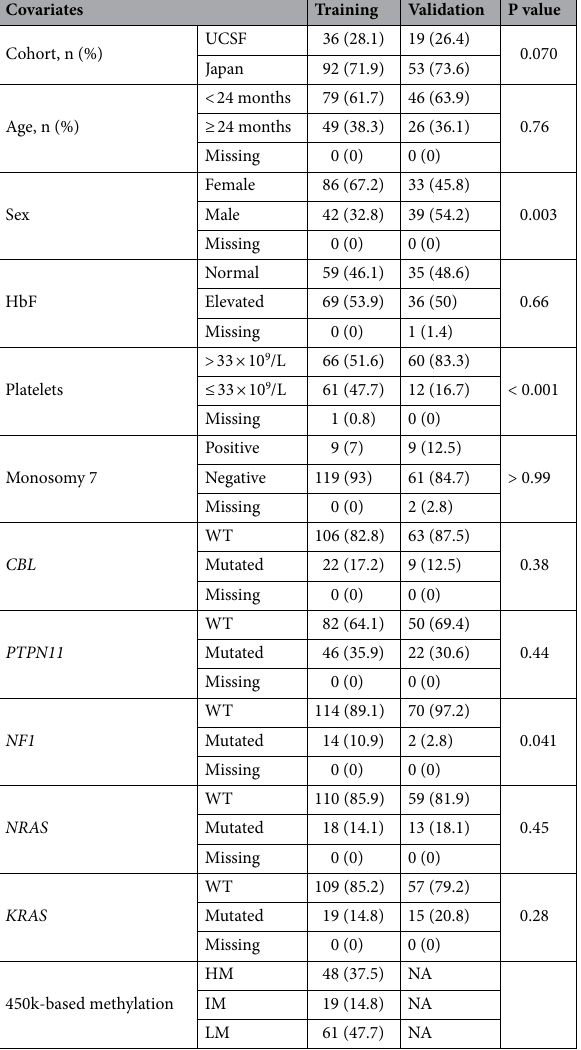
Table 1. Baseline characteristics of the training and validation cohorts. UCSF University of California, San Francisco, HbF hemoglobin F, WT wild type, HM high methylation, IM intermediate methylation, LM low methylation, NA not available.